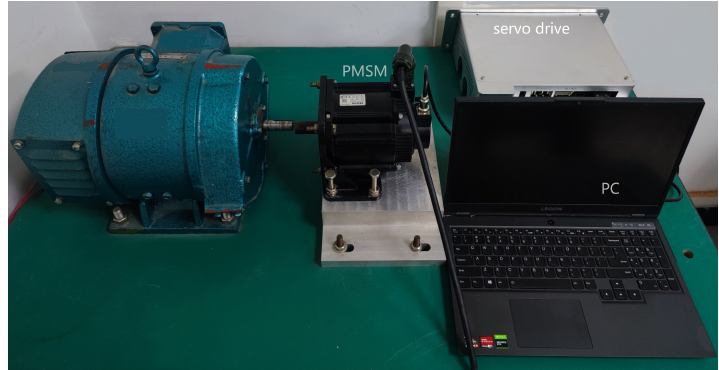
Figure 20. The experimental platform.